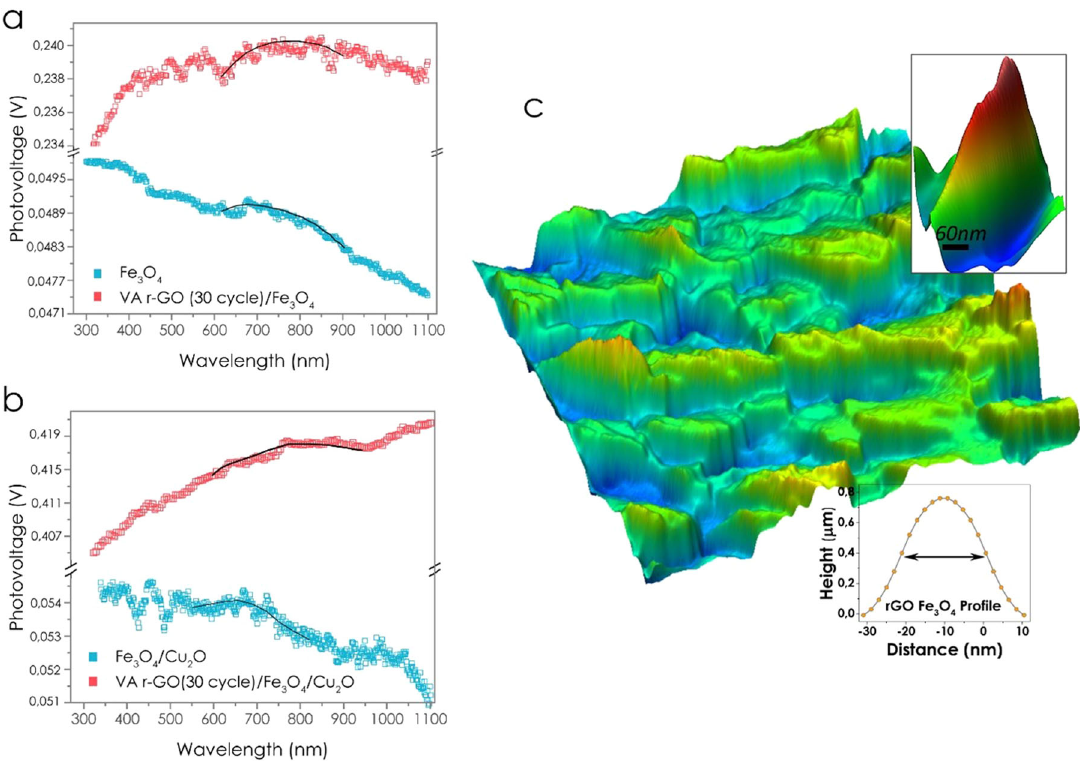
Fig. 4 Surface potential relaxation cascade of the composites. i Surface photovoltage spectroscopy of the ( a ) rGO integrated Fe 3 O 4 thin- fi lms compared to bare Fe 3 O 4 . b SPV of the hybrid p-n junctions prior and after VA rGO incorporation. The solid lines in the SPV spectra of the samples are refered to the baseline univariate normal distribution of the acquired data. c AFM image of the VA rGO/Fe 3 O 4 junction. Outset presents the nominal height pro fi ling of the sample ’ s